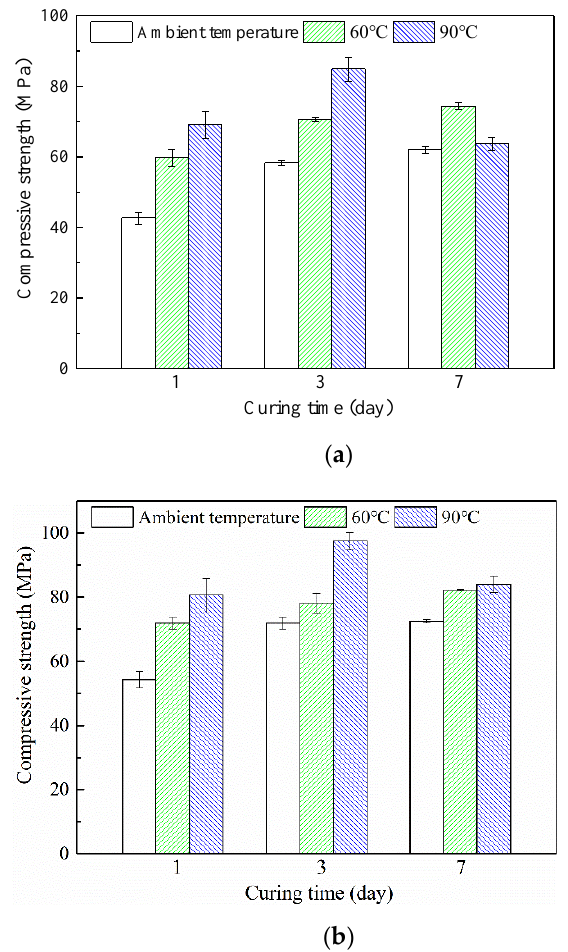
Figure 5. Compressive strength of HMGC under different curing conditions. ( a ) HMGC without steel fibers cured at different temperatures; ( b ) HMGC with steel fibers cured at different temperatures.